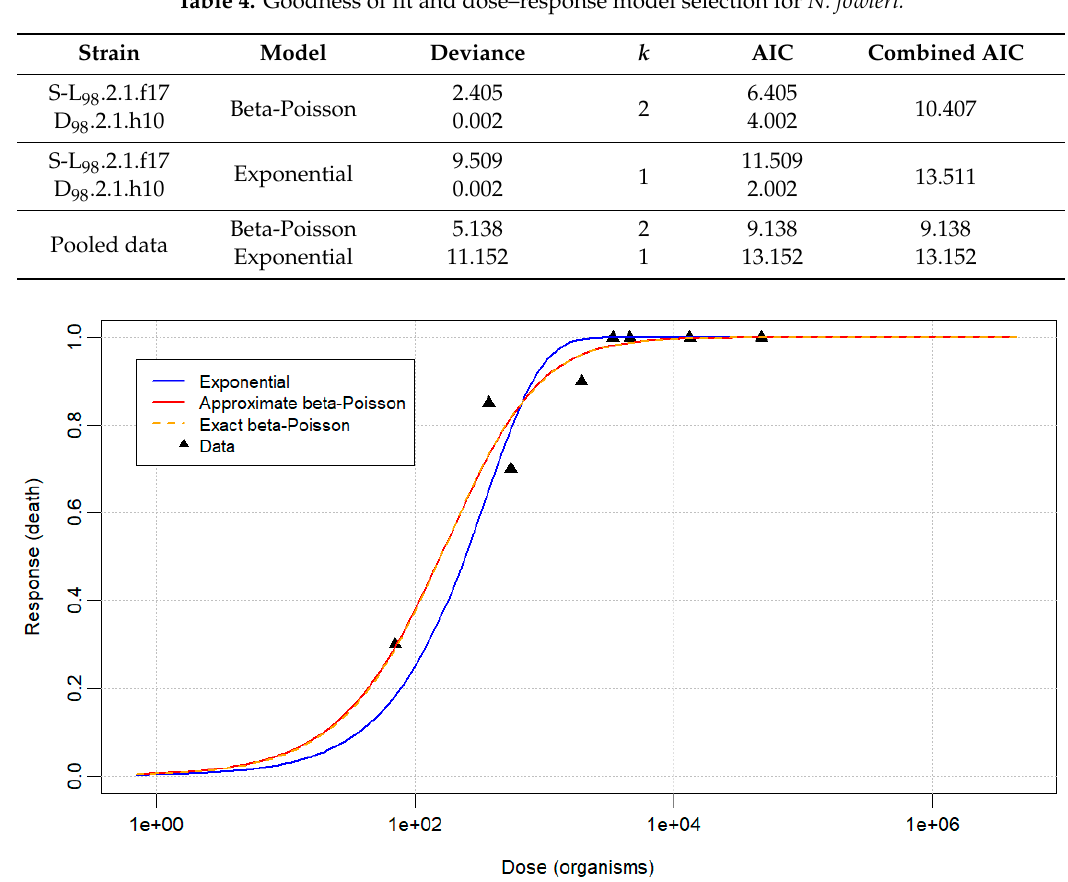
Figure 1. Plot of beta-Poisson and exponential model for pooled data. Table 4. Goodness of fit and dose–response model selection for N. fowleri.